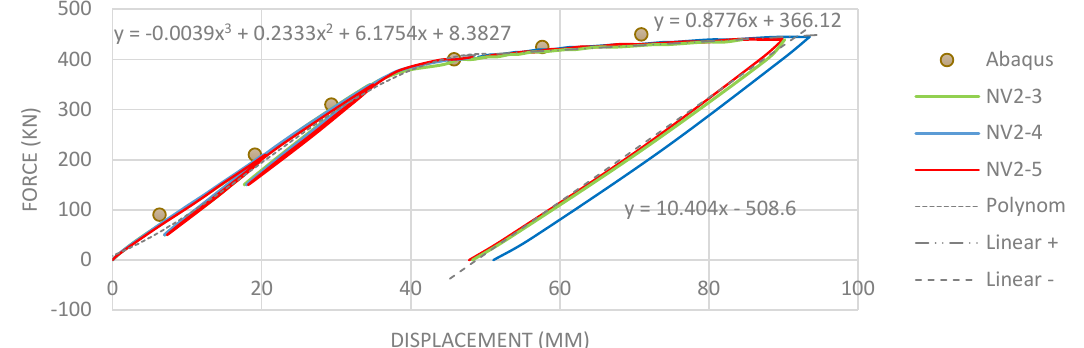
Fig. 6. Load-deflection relationship